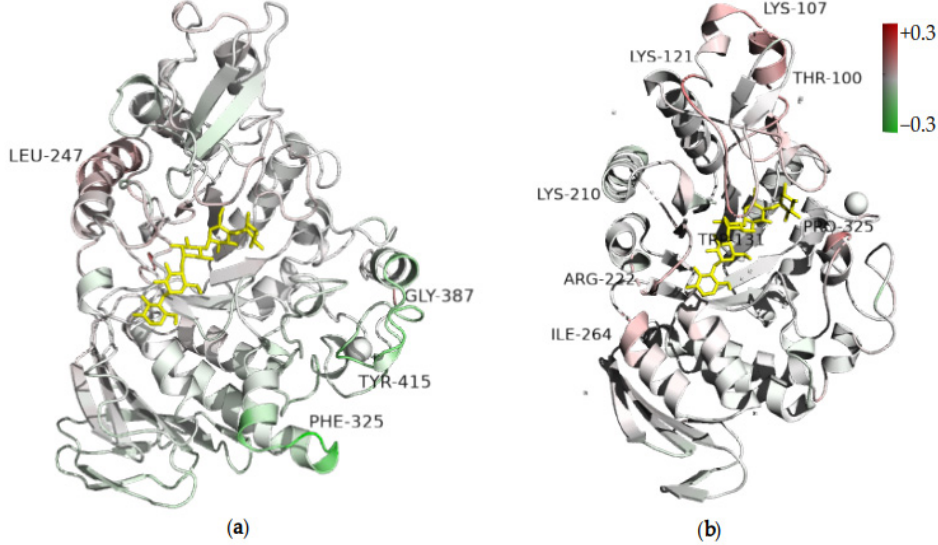
Figure 6. RMSF difference (in nanometers) along the structure with high and low transglycosidic variants of glycosidases. ( a ) TmAmyA K98P/D99A/H222Q triple mutant (less hydrolytic than the wild-type enzyme). ( b ) wild-type TmGTase (high transglycosidic) vs. T274V/M279N. The active center is delimited by acarbose (yellow stick) and is located away from the zone with the modified fluctuations. No differences in RMSF are shown in white, while positive or negative RMSF changes are red and green, respectively.